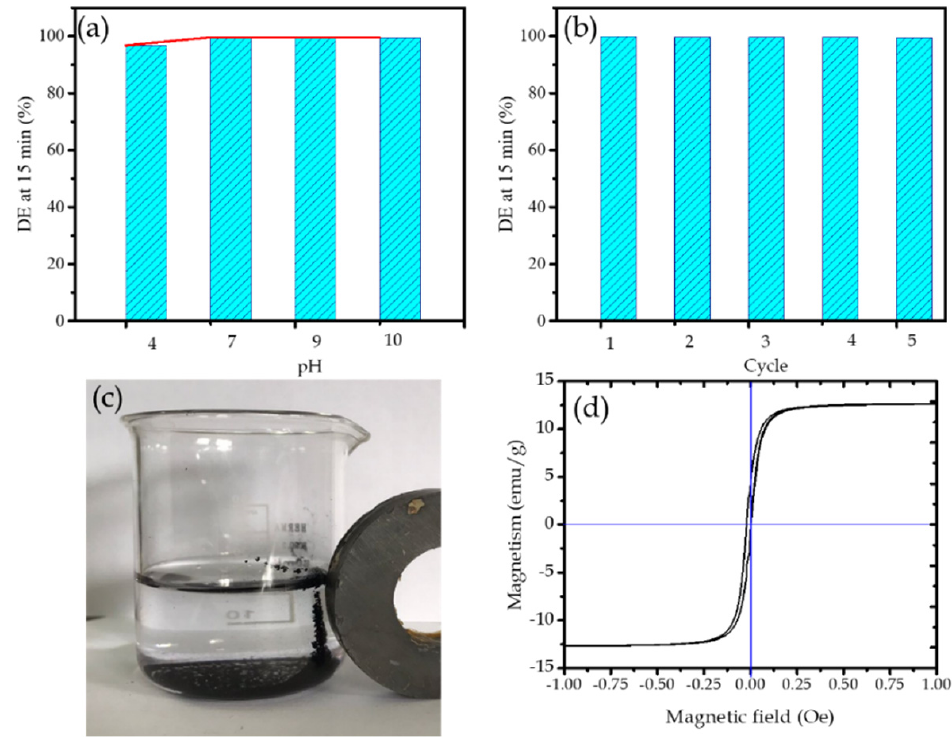
Figure 7. ( a ). Effect of pH on DE; ( b ). DE at varied cycles of Ni/BC usage in photooxidation; ( c ). Magnetic attraction of Ni/BC after usage; ( d ). VSM plot of magnetism of Ni/BC.